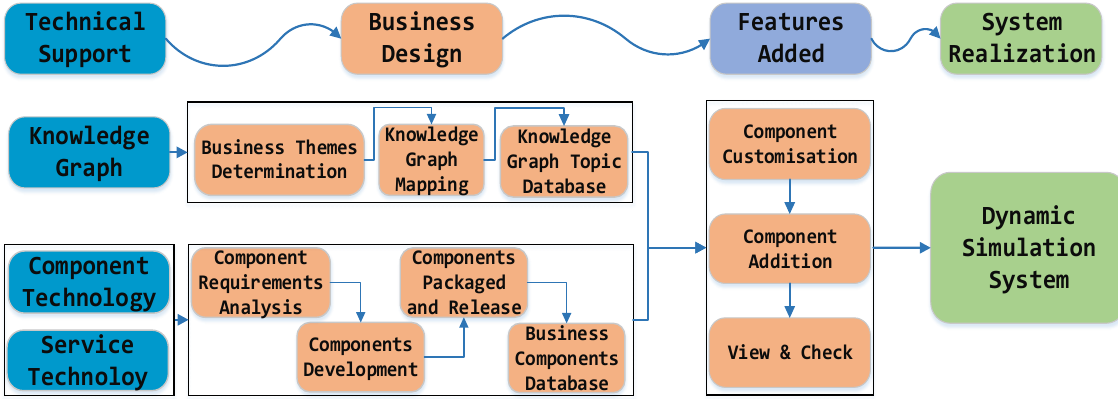
Figure 2. Construction process of simulation system.